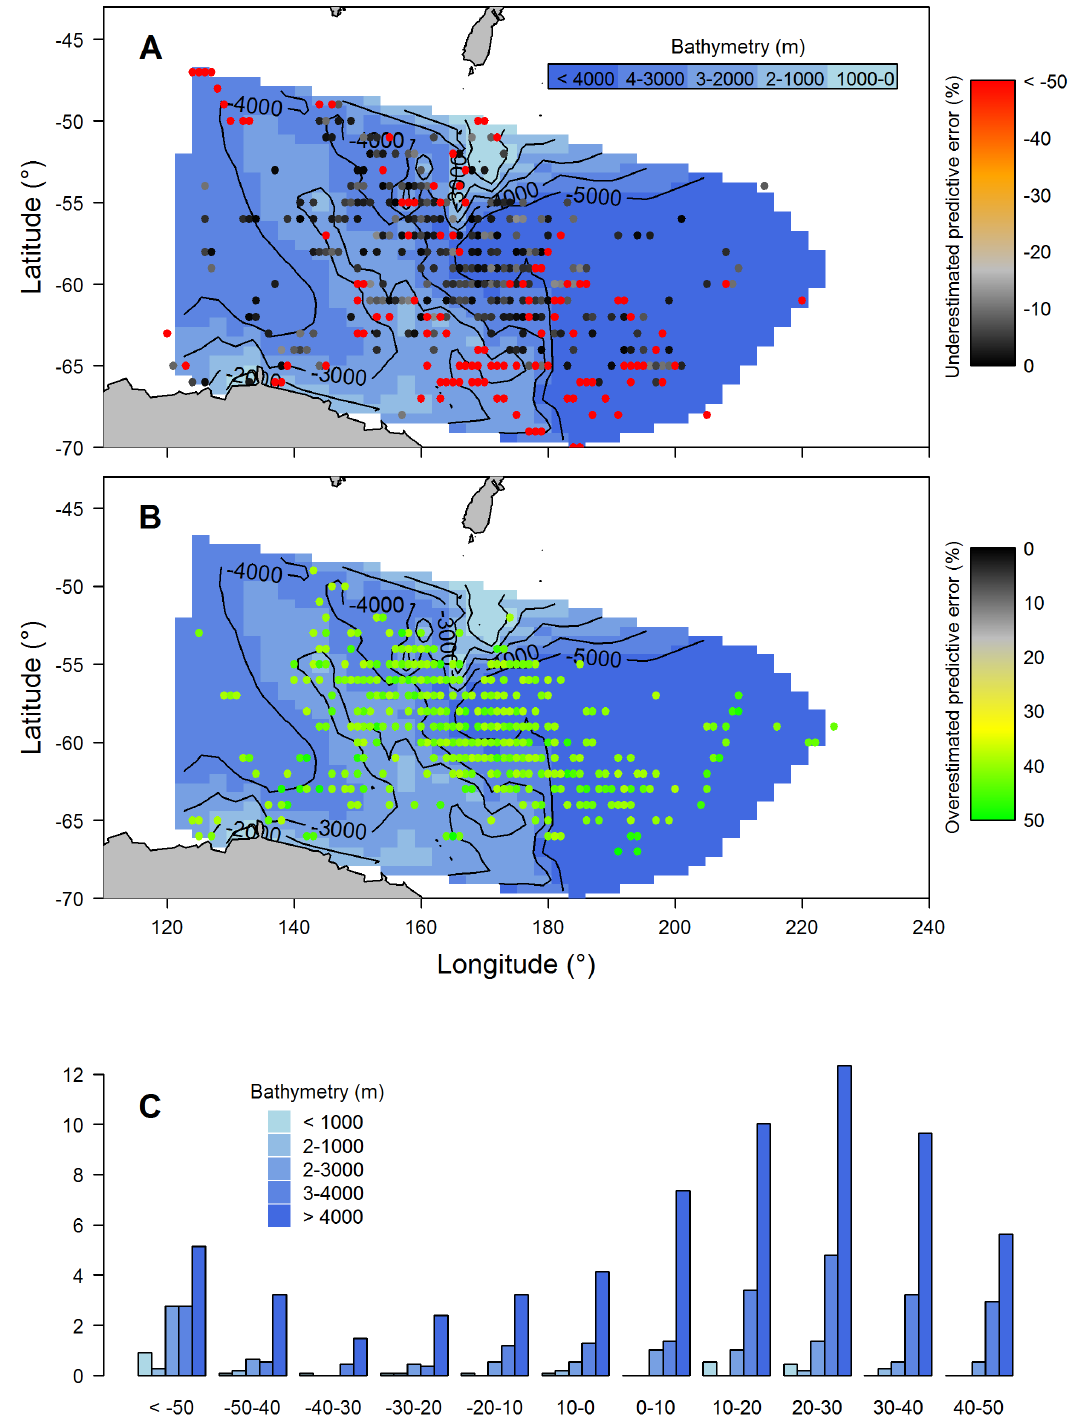
Figure 5. Spatial distribution of predictive chlorophyll-a error from our mixed model. Plots show locations associated with (A) underestimated predictive error (%), (B) overestimated predictive error (%), and (C) proportion (%) of locations with associated predictive error (%) in relation to bathymetric bands. doi:10.1371/journal.pone.0113171.g005 Light at 250 m generally coincides with the limit of the euphotic are representative of plankton densities. Our results show that chl- zone, so all photosynthetic organisms in the water column a (derived from satellite images) is significantly related to our phytoplankton index estimated from the integrated light attenu- influence light attenuation at this depth. In general, there is a ation recorded by TDLRs in the top 250 m of the water column. good relationship between chl-a concentration within the top 30 m